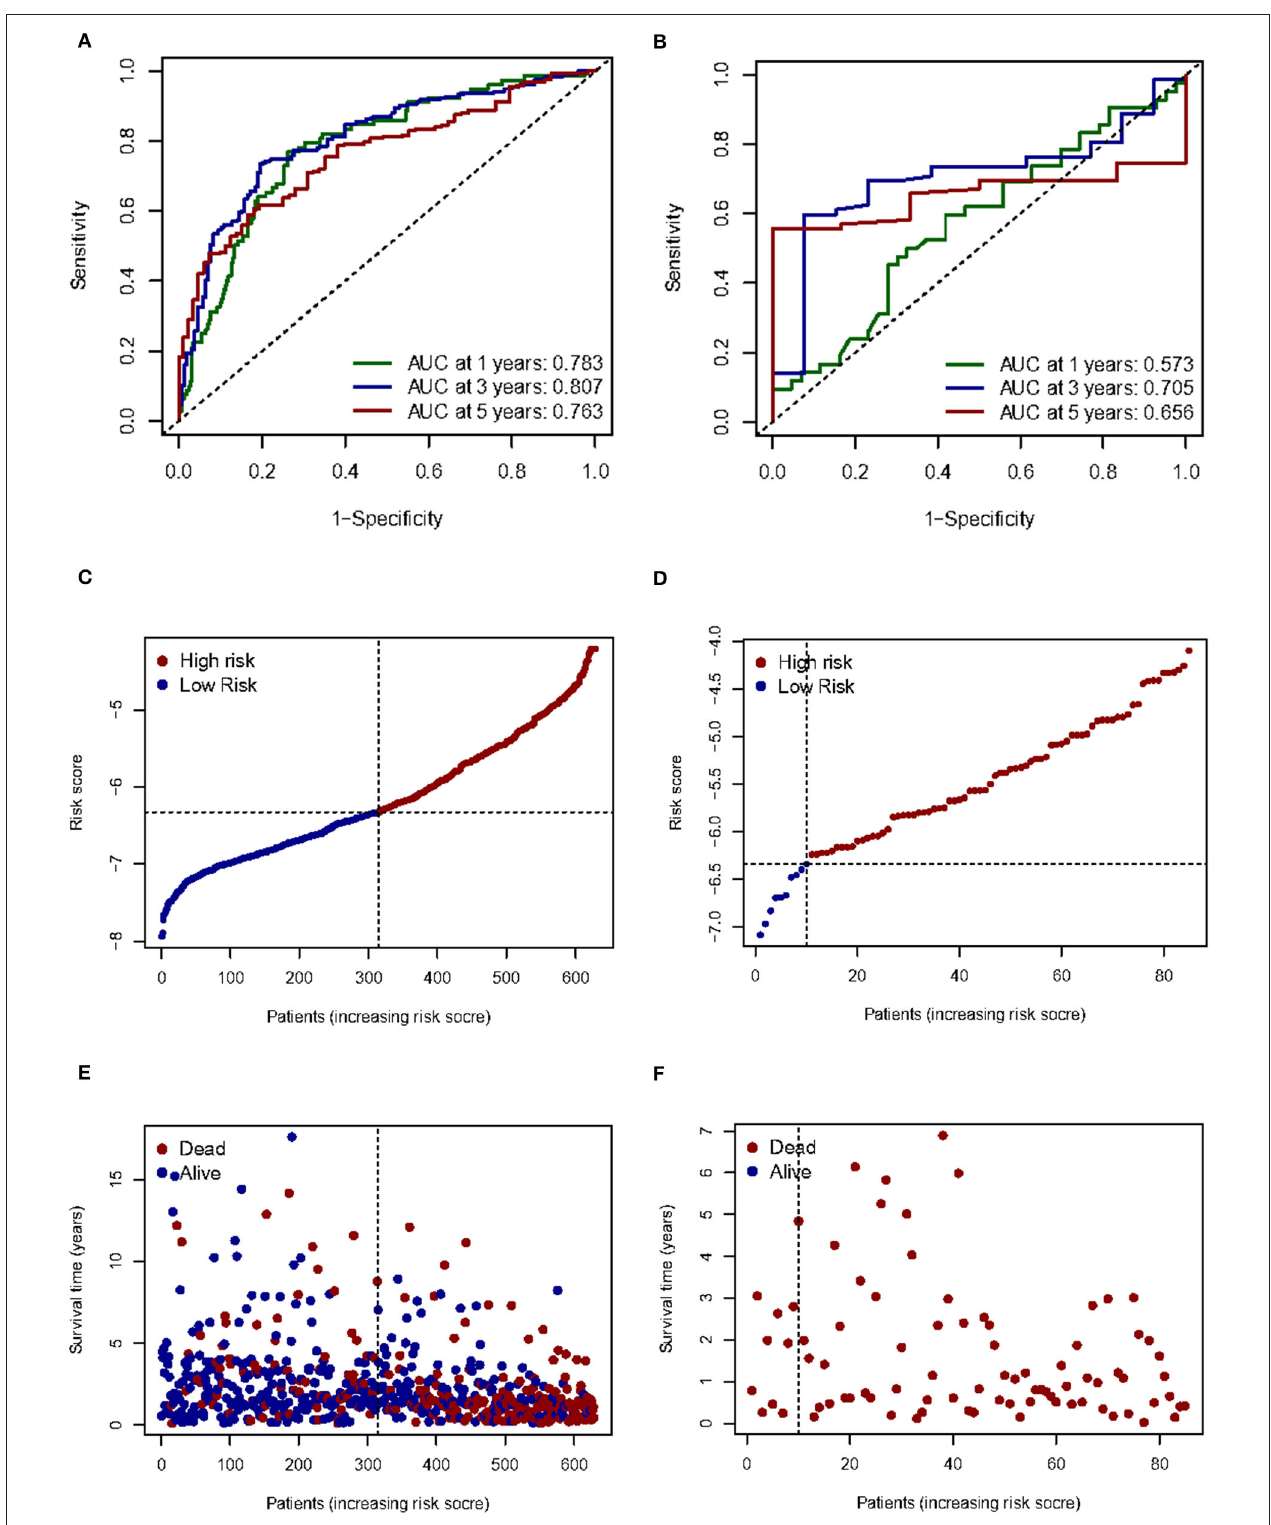
FIGURE 7 | Prognostic value of three m7G RNA methylation regulators. (A, B) In the TCGA and GEO databases, the receiver operating characteristic (ROC) curves demonstrate the risk scores’ predictive ability for patient survival at 1, 3, and 5 years. (C,D) Distribution of risk scores for glioma patients. (E,F) Survival status of each